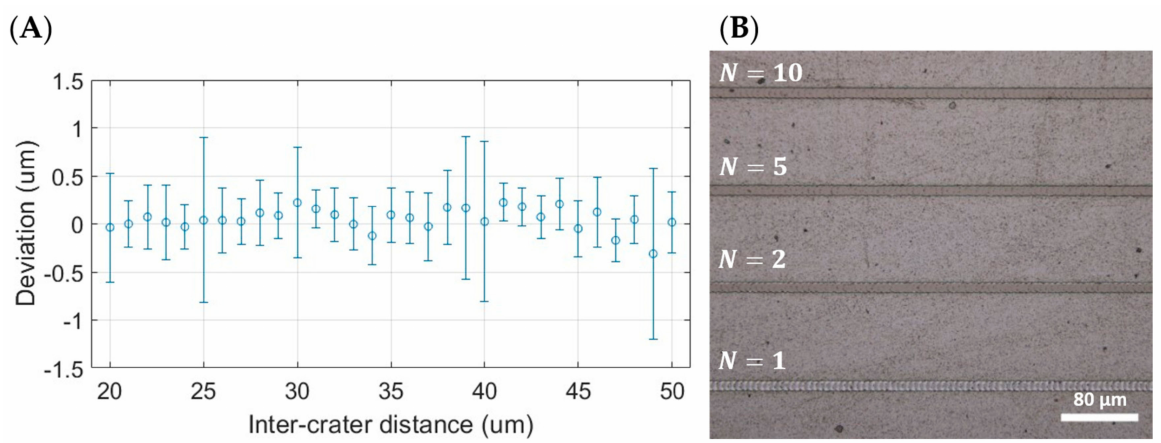
Figure 3. ( A ) Graph showing the deviation from the expected intercrater distance at various in- tercrater distances and at maximal scanning speed (20 m/s). ( B ) Examples of ITO isolation using multiple high-speed scanning passes and an optimized fluence to achieve clean lines with minimal effects on the surrounding material. Scale bar is equal to 80 µ